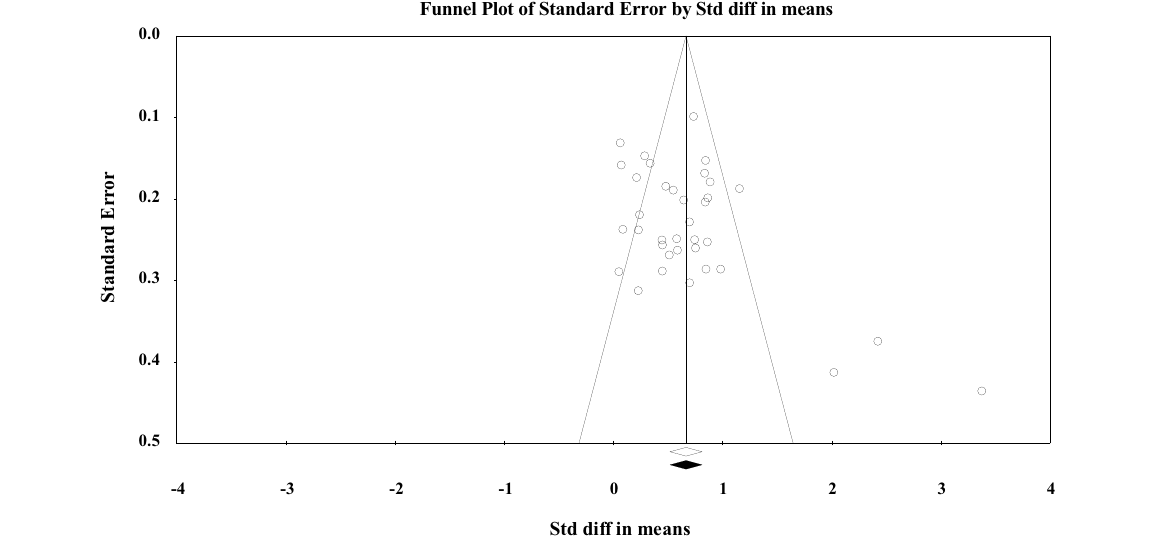
Fig. 2 Funnel plot of effect sizes with 95% confidence interval